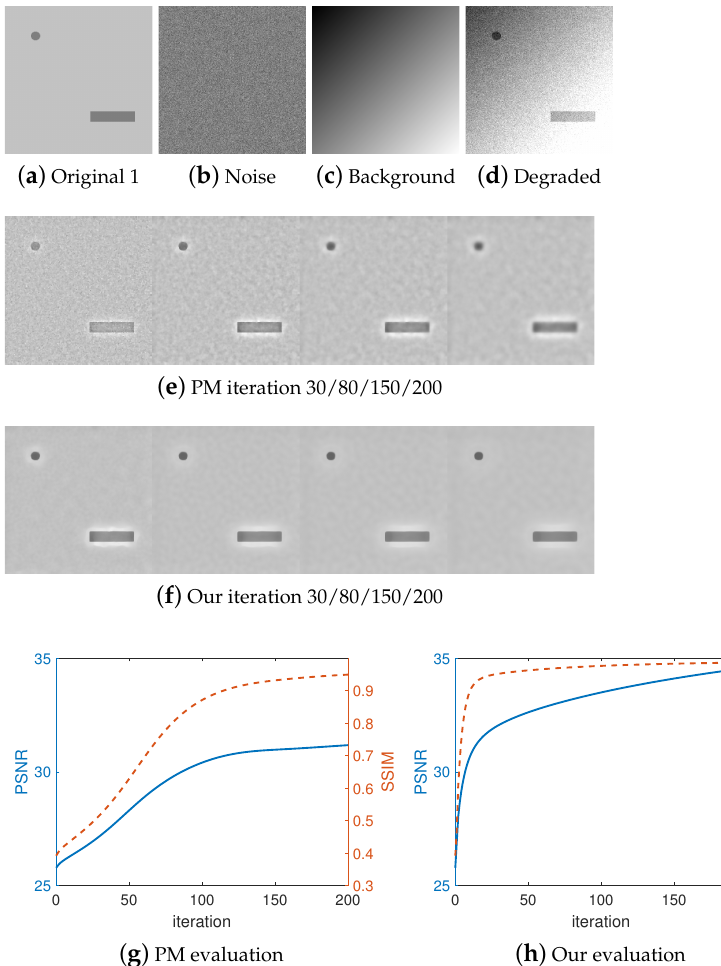
Figure 1. Traditional result and our result on artificial image